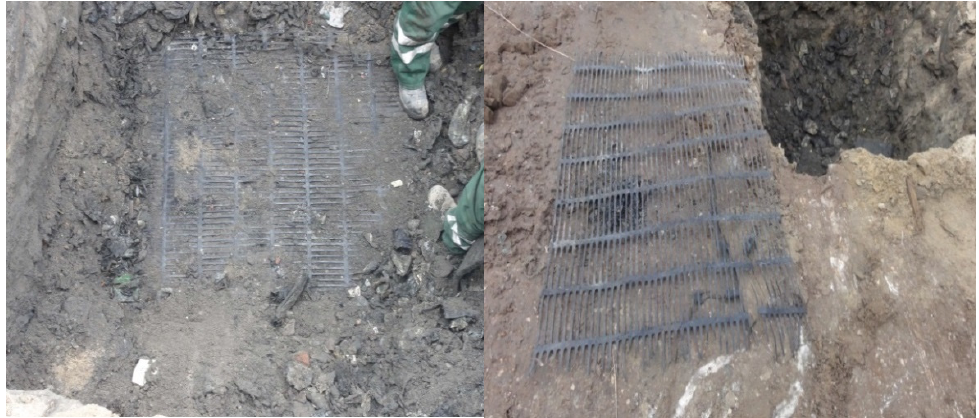
Figure 4. Geogrid HDPE samples collected after 20 years of service.